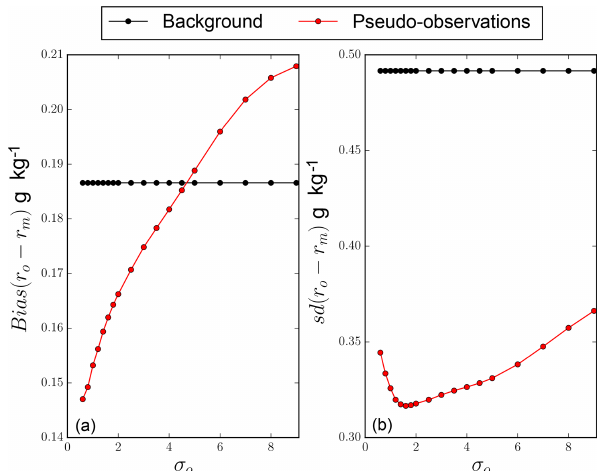
Figure 4. Standard deviations ( b , in gkg − 1 ) and biases ( a , in gkg − 1 ) of the water vapour mixing ratio differences between in- flight measurements, r q , and the retrieved ones, r m (red), as a func- tion of the error standard deviations σ o (in dB). The standard de- viations and biases before applying the 1-D Bayesian retrieval are represented by the black data